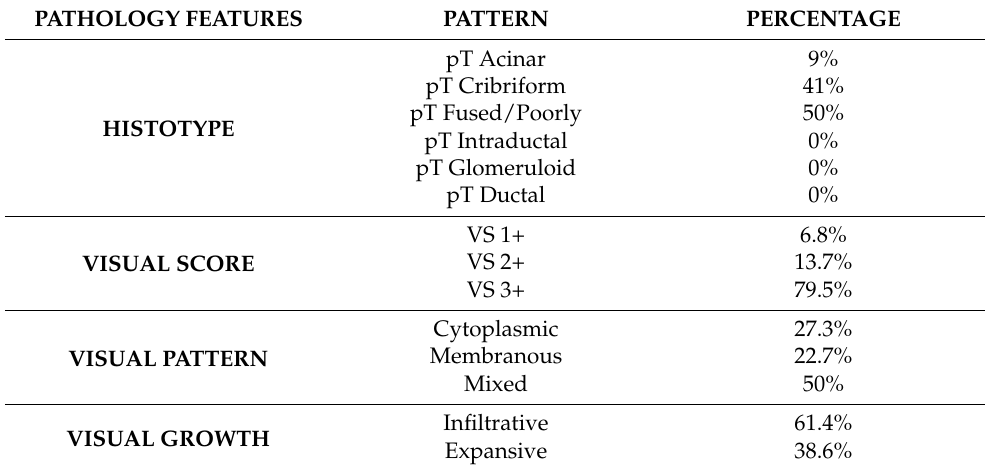
Table 2. Pathology features’